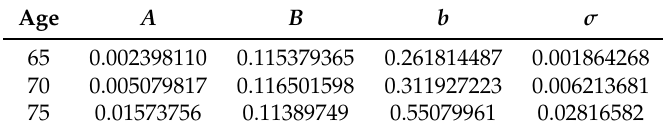
Table 3. Optimal parameters values for the survival function in the CIR model.